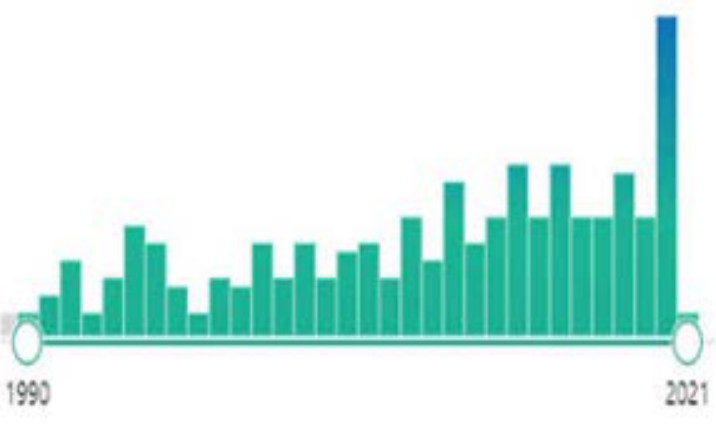
(Medical Literature Analysis and Retrieval System Online – MEDLINE).